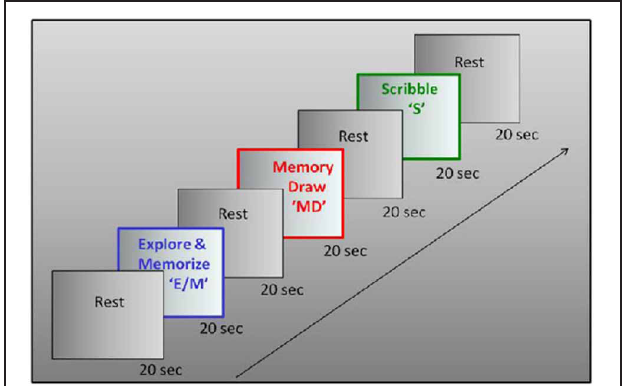
FIGURE 2 | Experimental design. Drawing was investigated in a three-phase paradigm consisting of a memory-guided drawing task, abbreviated as “ MemoryDraw” (MD) , plus two control tasks: a motor and “ negative ” memory control task “ Scribble” (S) , and a task of perceptual exploration and memorization of the model to be drawn “ Explore/Memorize” (E/M) . Each task duration was 20s, with 20s rest intervals elapsing between the tasks, with the whole trial sequence being repeated 12 times in each scanning session.